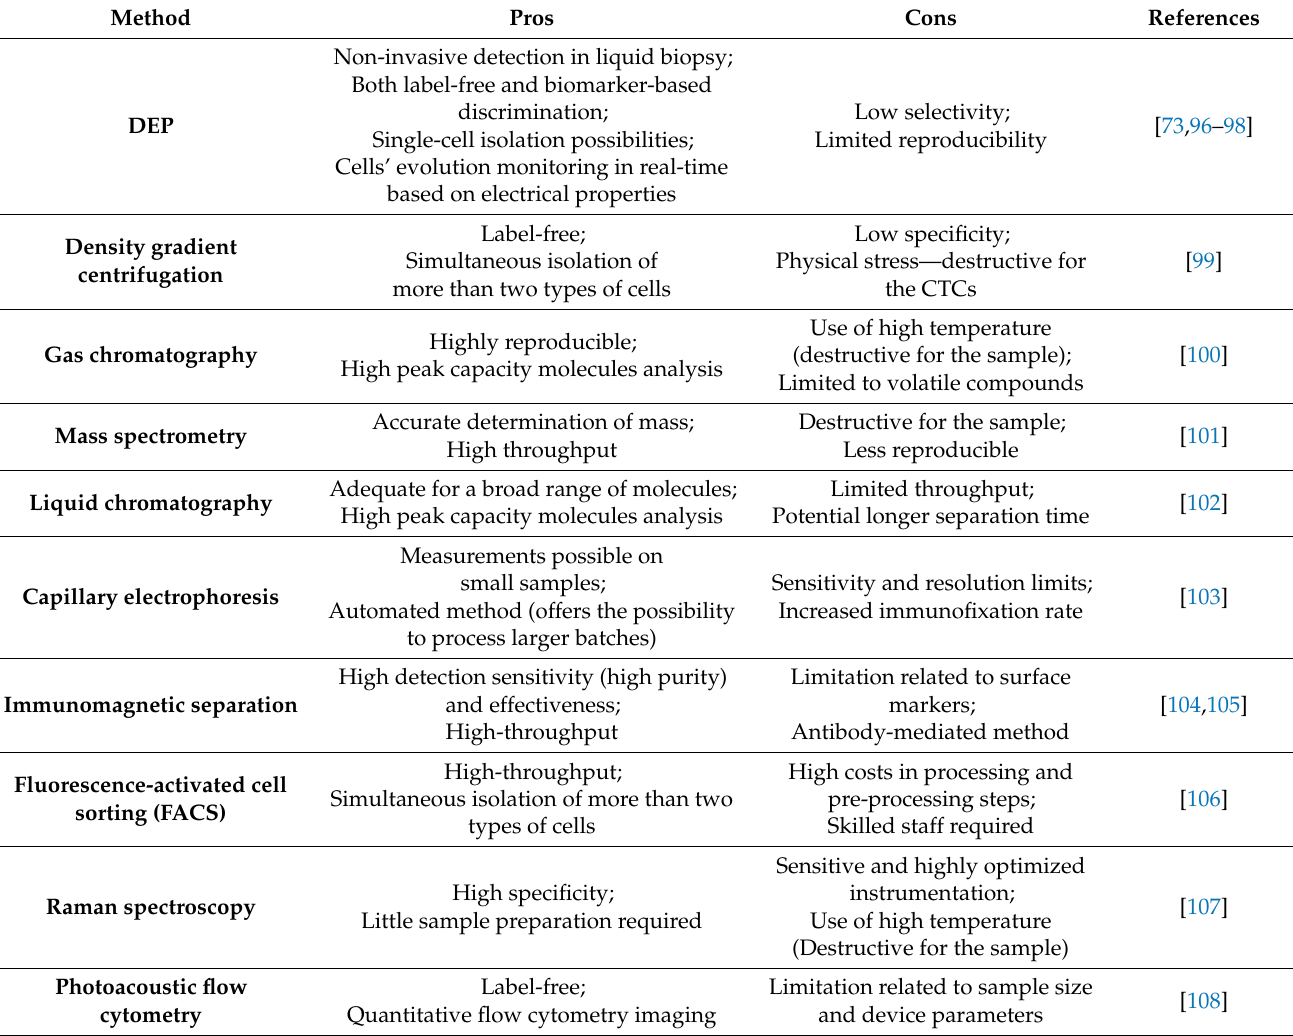
Table 3. Pros and cons of dielectrophoresis vs. other CTCs detection and separation